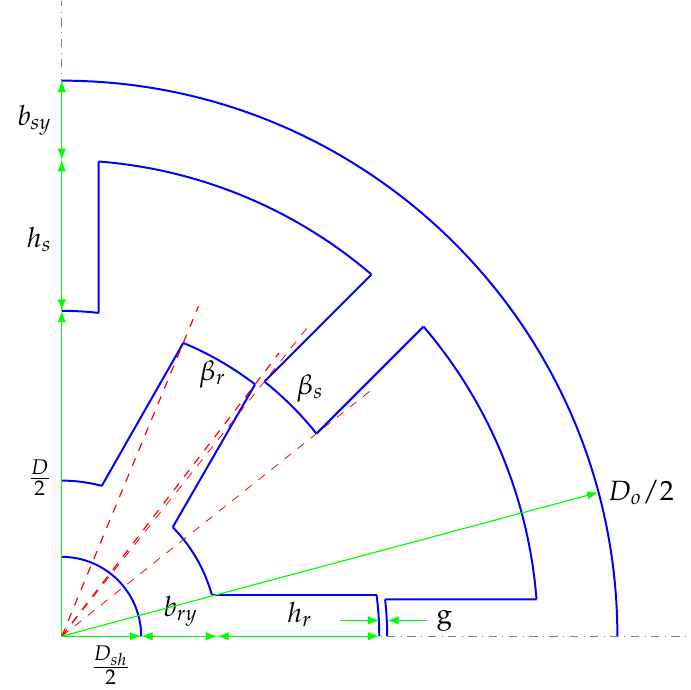
Figure 1. The lamination dimensions considered in the optimization